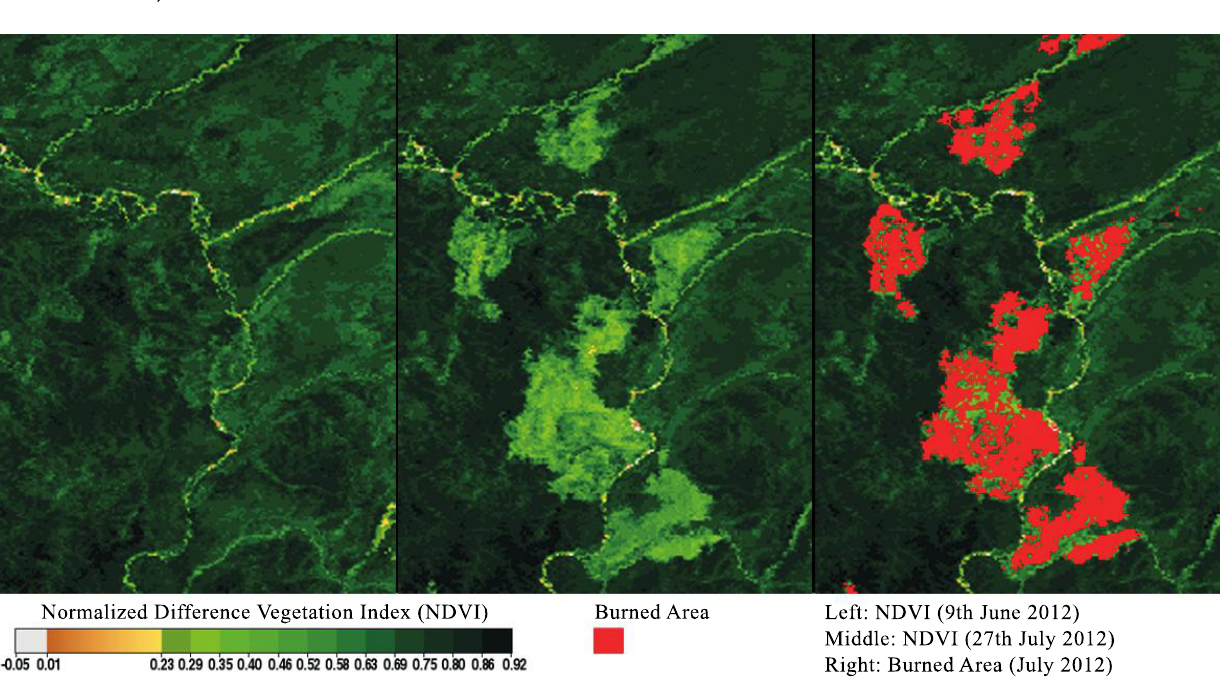
Figure 9. Combination of MODIS NDVI and MODIS burned area datasets ( Left : previous-fire NDVI; Middle : post-fire NDVI, Right : burned areas)